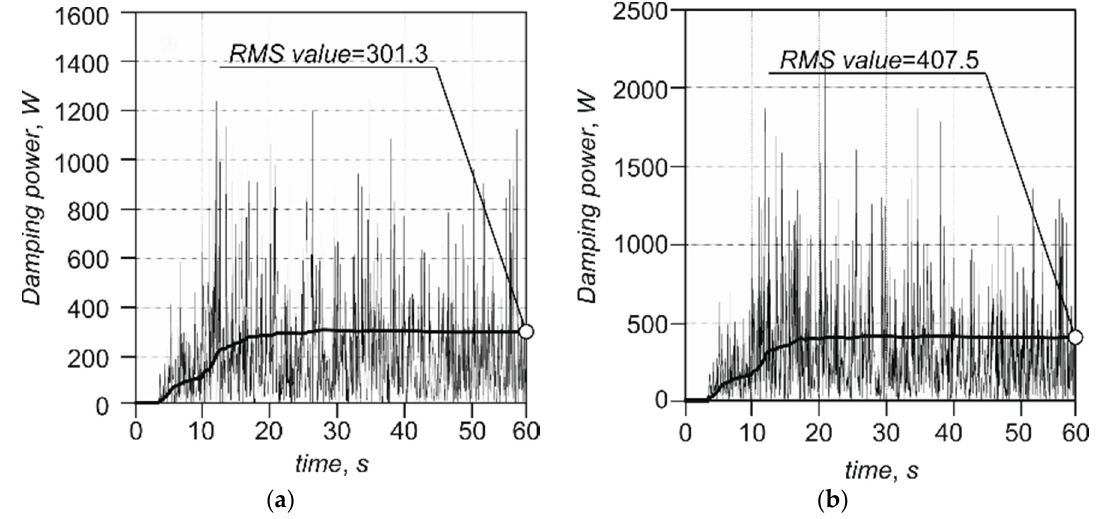
Figure 6. Damping power dependencies over time, obtained from the model for road no. 6: ( a ) Permanent damping with h SF 1 = 7500 Ns/m; ( b ) Optimized damping law. RMS—root mean square.